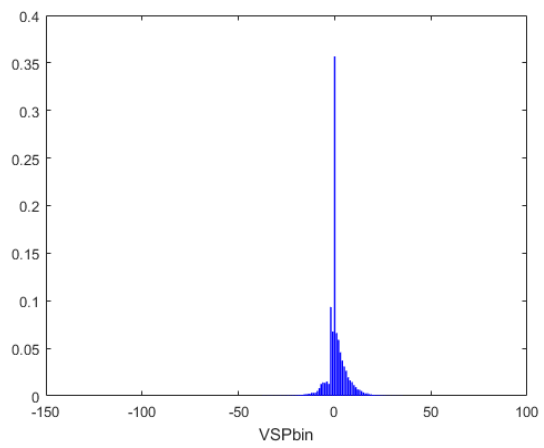
Figure 2. The Vehicle Specific Power (VSP) distribution.